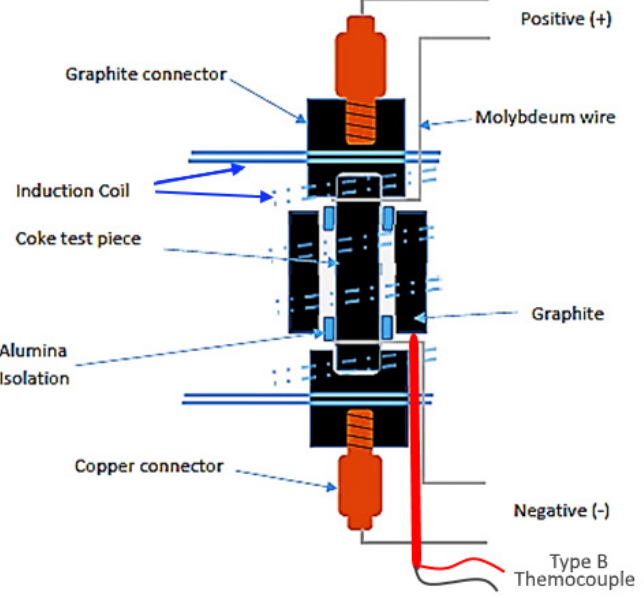
Figure 4. Schematic representation of the arrangement to measure high-temperature resistivity.